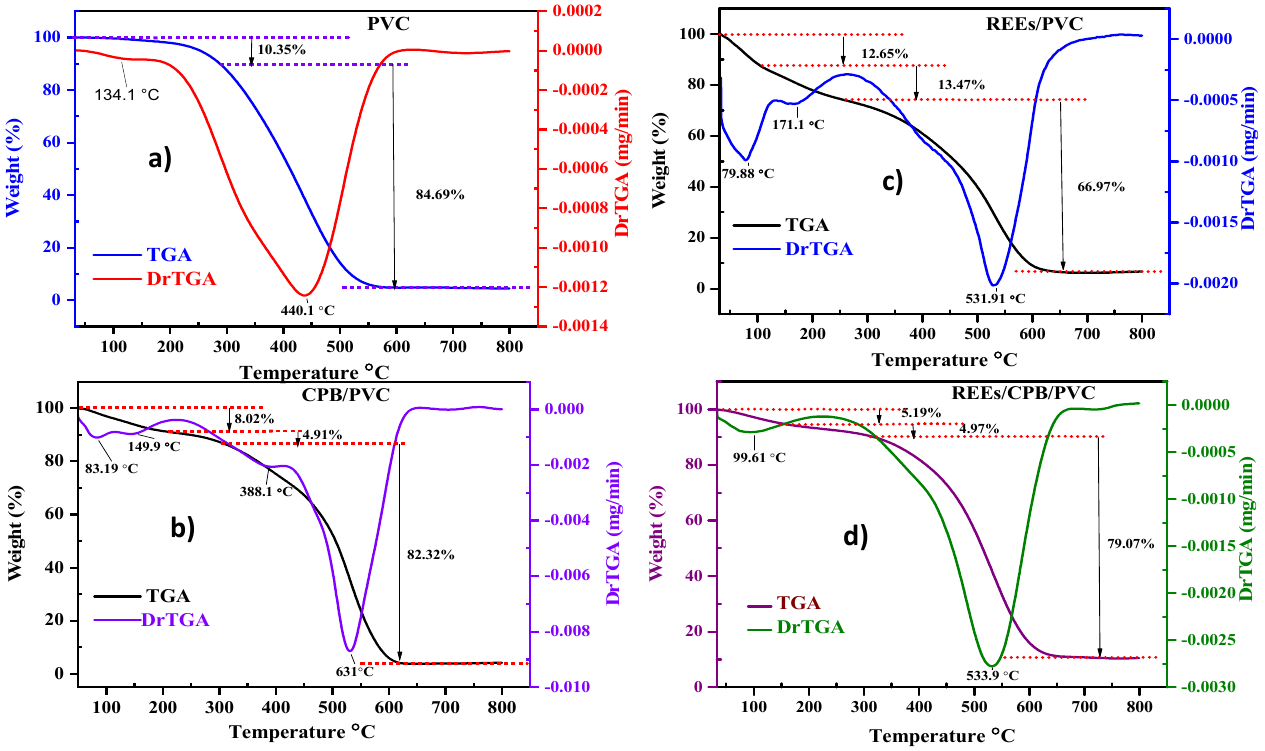
Figure 5. TGA analysis of ( a ) PVC, ( b ) CPB/PVC, ( c ) REEs/PVC, ( d ) REEs/CPB/PVC.